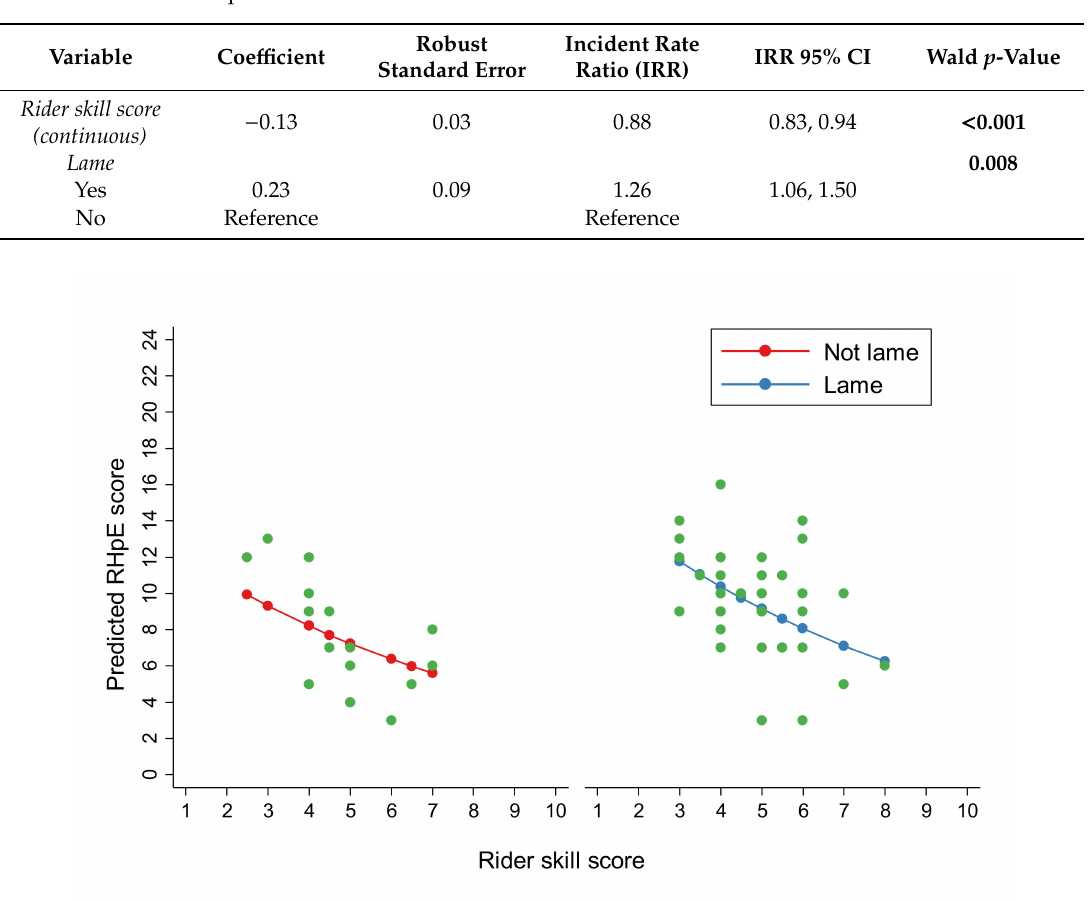
Table 4. The final multivariable Poisson regression, including robust standard errors, of signalment, work discipline and lameness-related variables associated with Ridden Horse Pain Ethogram scores in a convenience sample of 60 horses. CI = confidence intervals.